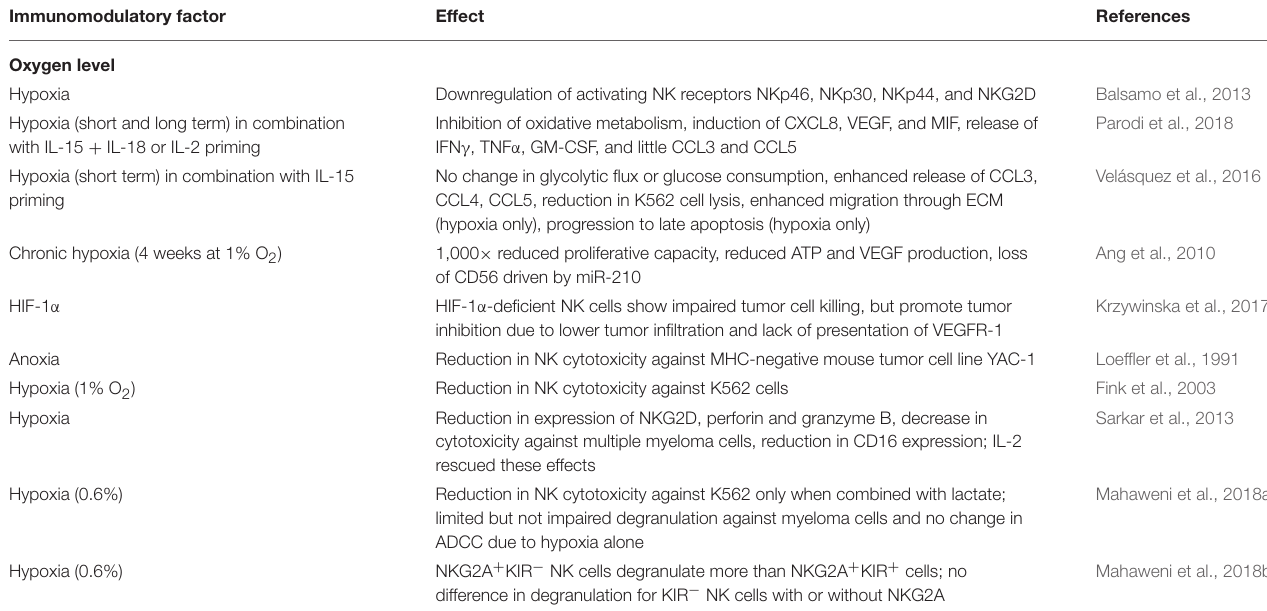
TABLE 1 | Effects of hypoxia on NK cell function and